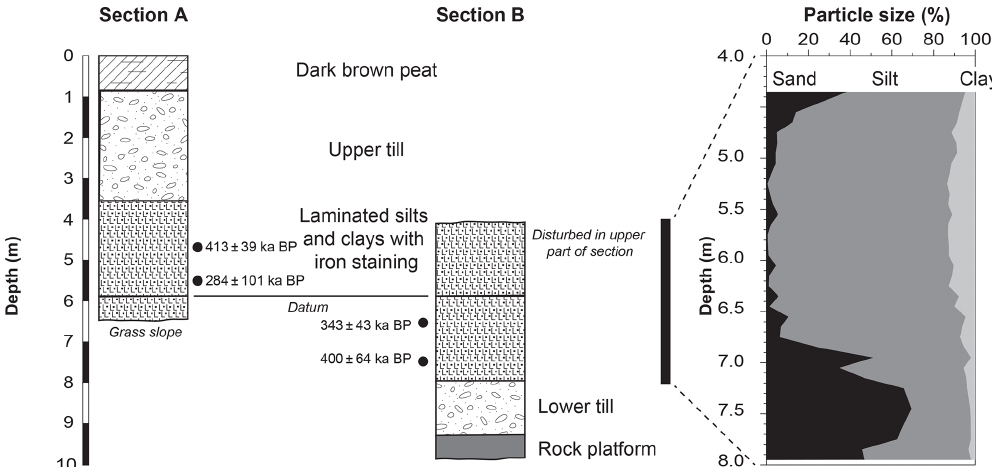
Figure 4. Schematic of the exposed “Enderby Formation” on Enderby Island. Optical dating sample locations shown by black circles (Enderby-1 at the bottom, Enderby-4 at the top). Particle size analysis of laminated silts enlarged at right. Sections A and B are separated by an eroded “step”, but have multiple prominent lithostratigraphic layers which extend from one section to the other (see Fig.